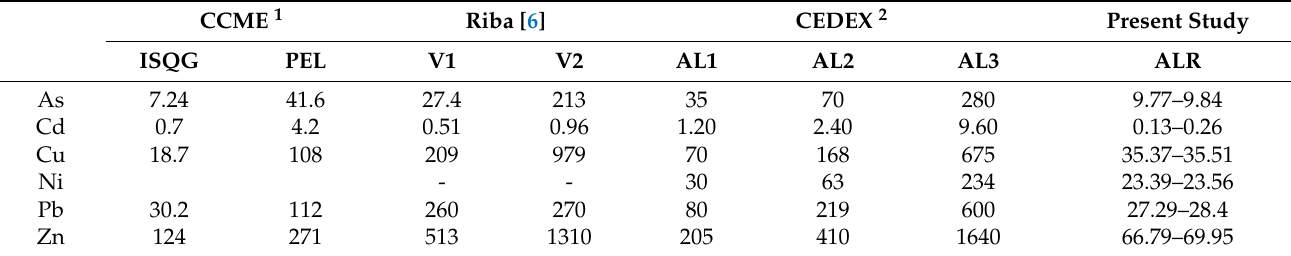
Table 4. SQGs comparison for marine